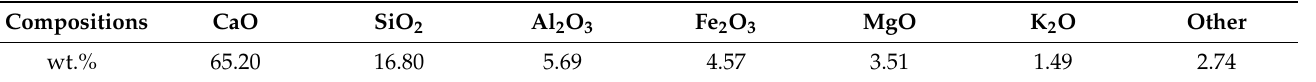
Table 3. Chemical compositions of tailings.